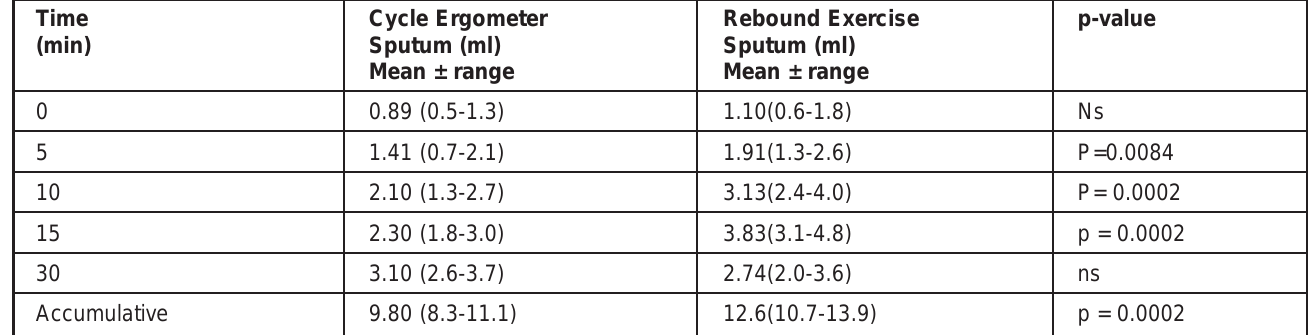
Table 2: Sputum Production at different time points per exercise performed Time